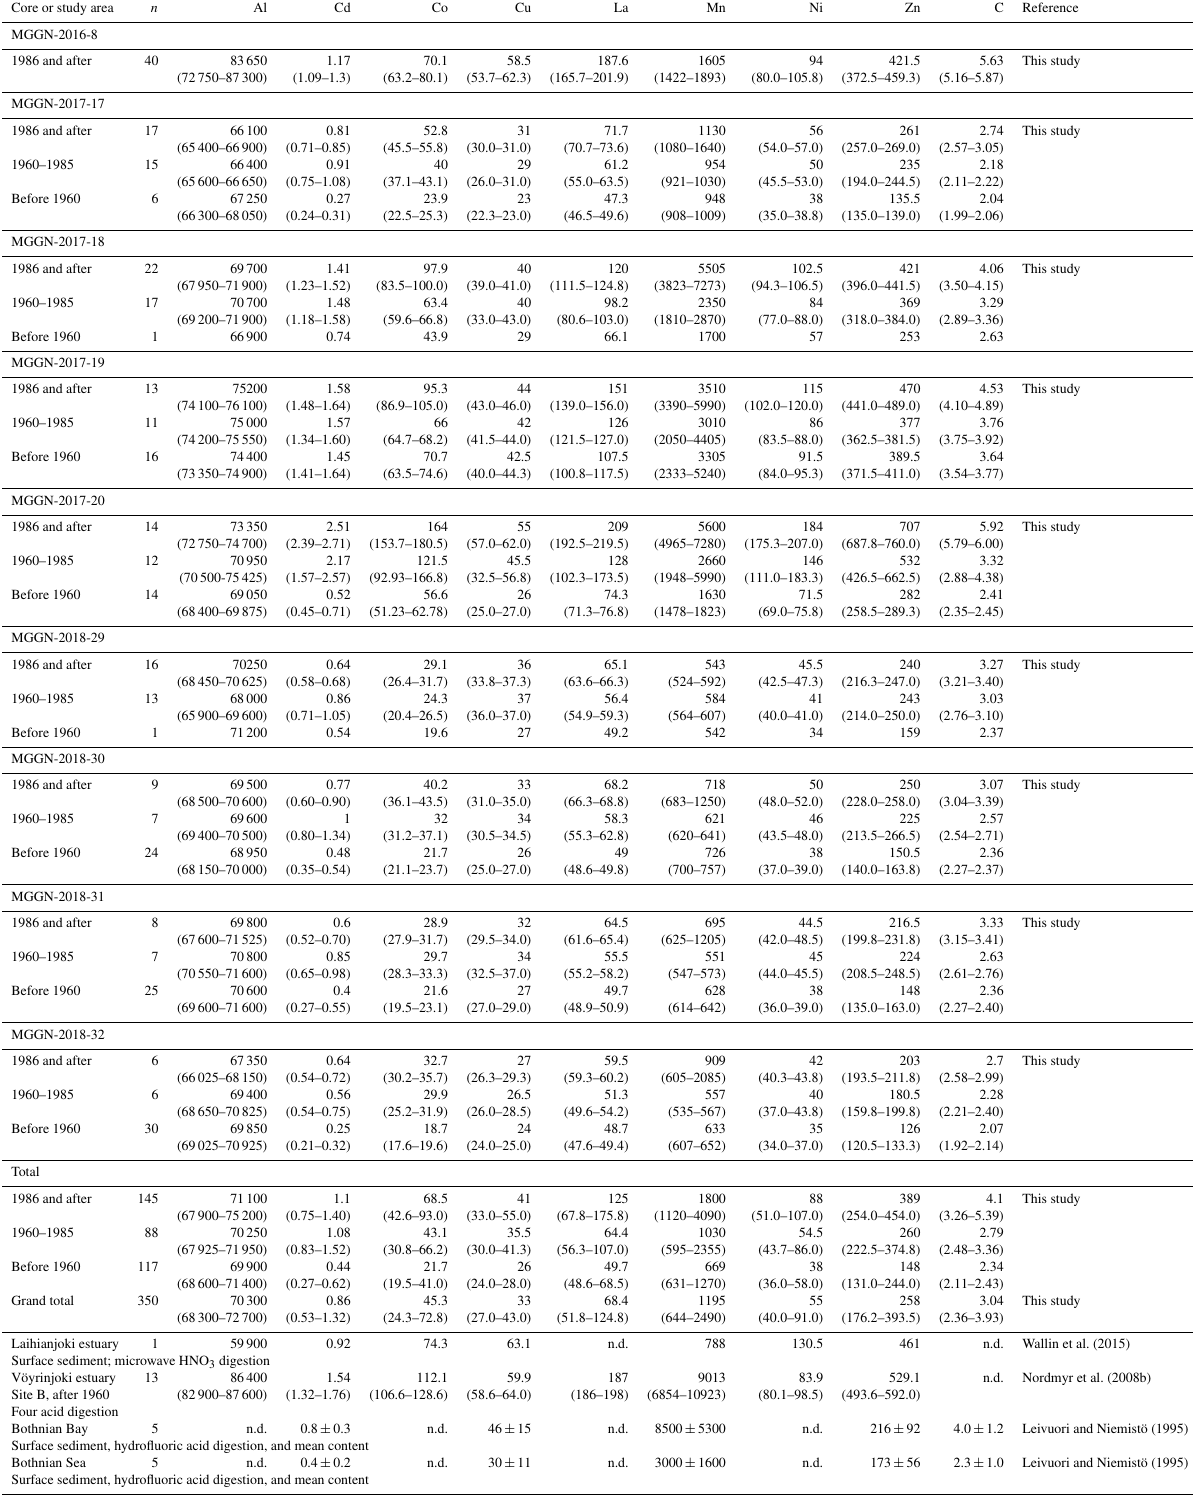
Table 2. Median metal and carbon contents in sediment samples, with interquartile ranges in